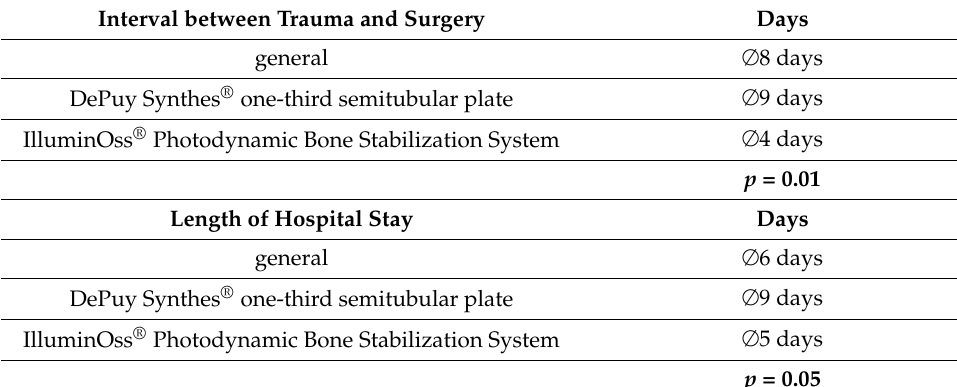
Table 6. Interval between trauma and surgery as well as mean length of hospital stay for both groups. Interval between Trauma and